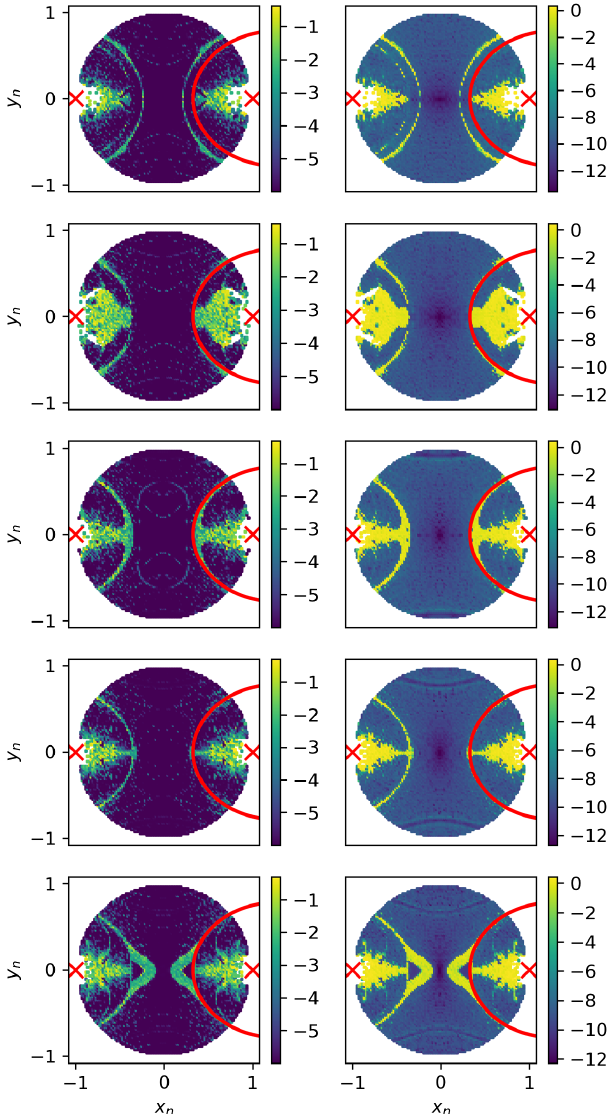
FIG. 23. Dynamic aperture of the IOTA toy-model at various − y values of ν with δμ ¼ 0 . 01 . From top to bottom: ν ¼ 0 . 28 , 0.3, plane n n 0.32, 0.34 and ν ¼ 0 . 36 . The left column is obtained using FMA and the right column is obtained using